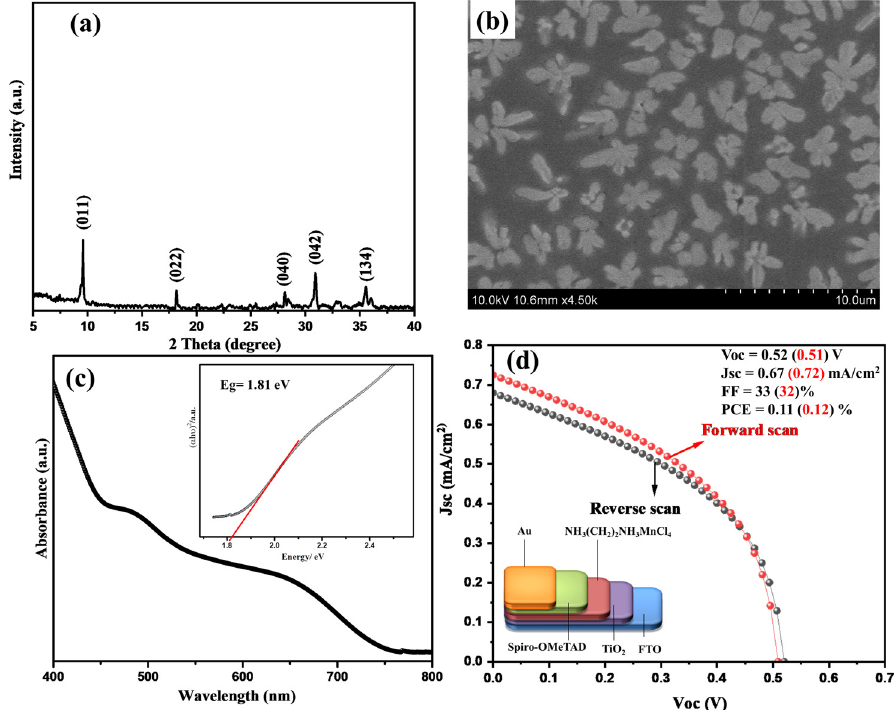
Figure 7. XRD ( a ), SEM ( b ), and UV ‐ vis spectrum ( c ) of NH 3 (CH 2 ) 2 NH 3 MnCl 4 (Inset shows Tauc plot). J ‐ V curve ( d ) of fabricated PSCs.